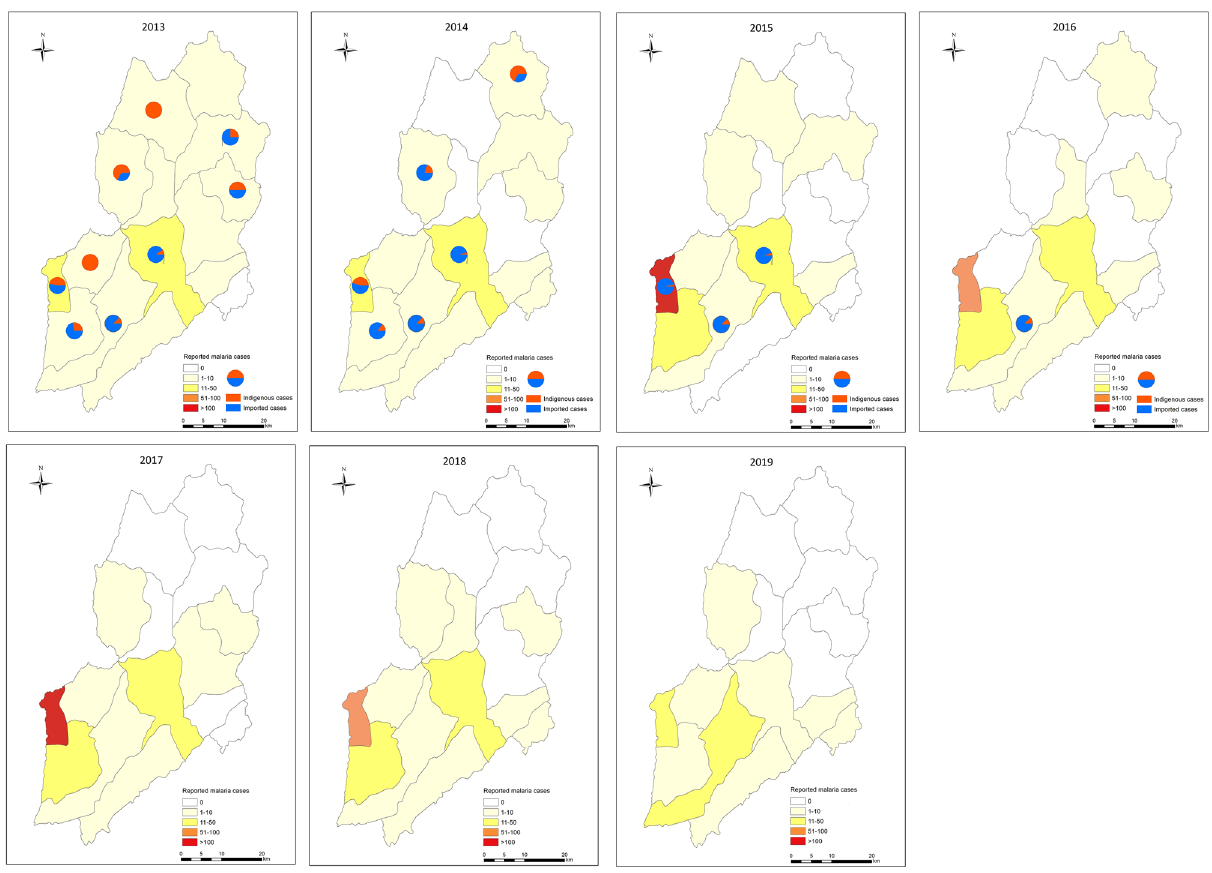
Figure 1. The number of reported malaria cases in 15 townships and the proportion of indigenous and imported cases at the township level. Townships was colored based on the number of reported malaria cases in each year. The pie indicates the proportion of indigenous cases and imported cases in the townships with indigenous cases reported in 2013–2016. Maps were created by the first author (FH) using ArcGIS version 10.1, https:// www. arcgis. com, and data of malaria cases were from publicly available sources (CIDRS, Malaria Elimination Programme,